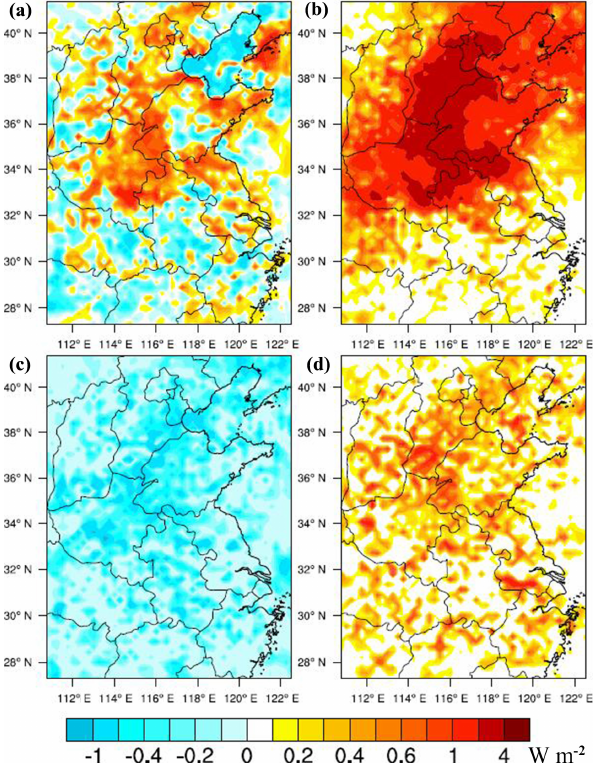
Figure 6. Spatial distribution of simulated direct radiative effect (DRE) introduced by (a) all aerosol from crop residue burning and (b) BC from crop-burning, (c) OA from crop burning and (d) the absorbing component of OA from crop-burning emissions, calcu- lated from WRF-Chem simulations during the summer harvest (1– 21